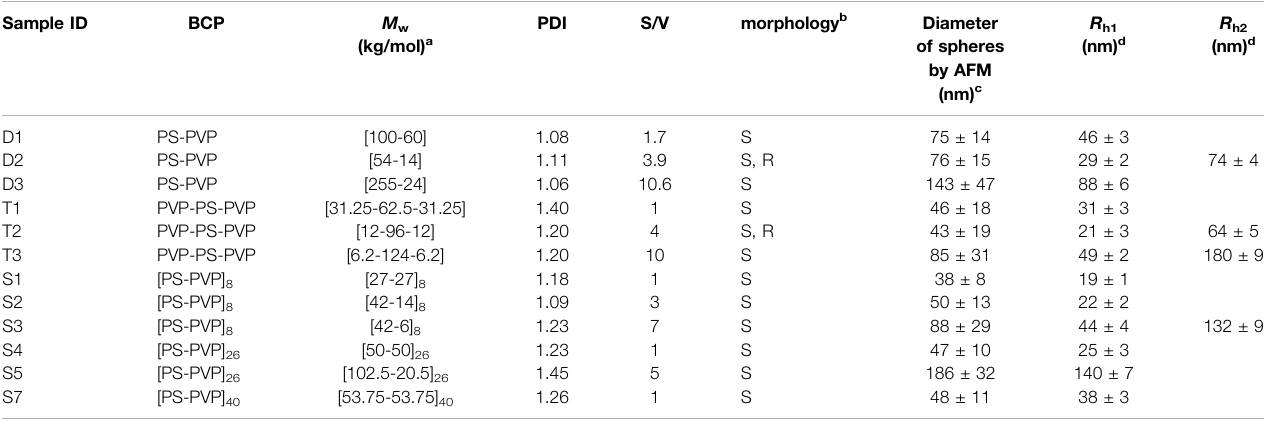
TABLE 1 | Properties of PS – PVP BCPs and characteristics of their BCP NPs. Sample